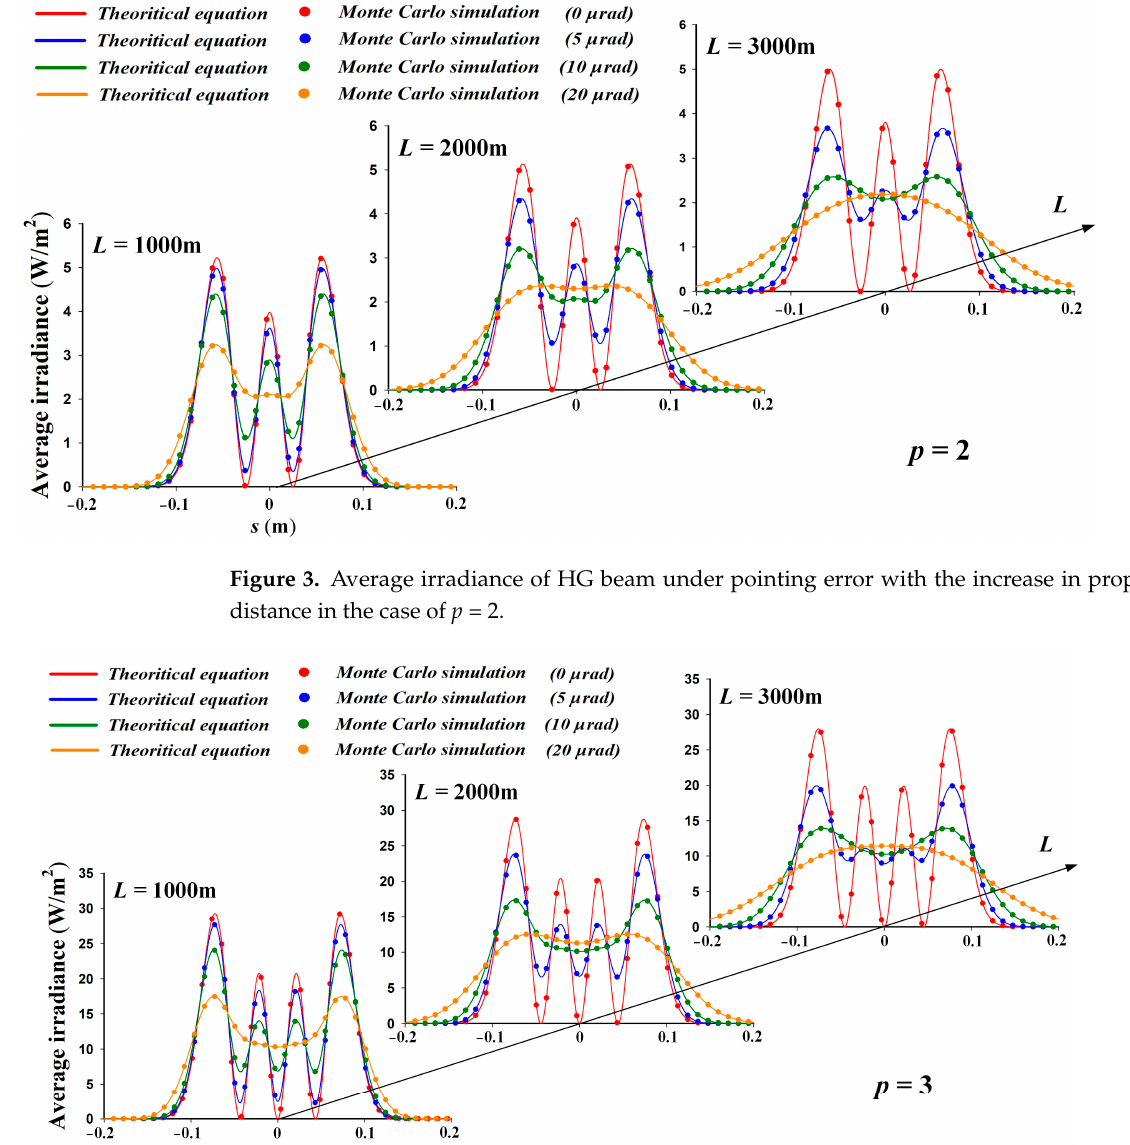
Figure 2. Average irradiance of HG beam under pointing error with the increase in propagation distance in the case of p = 1 .